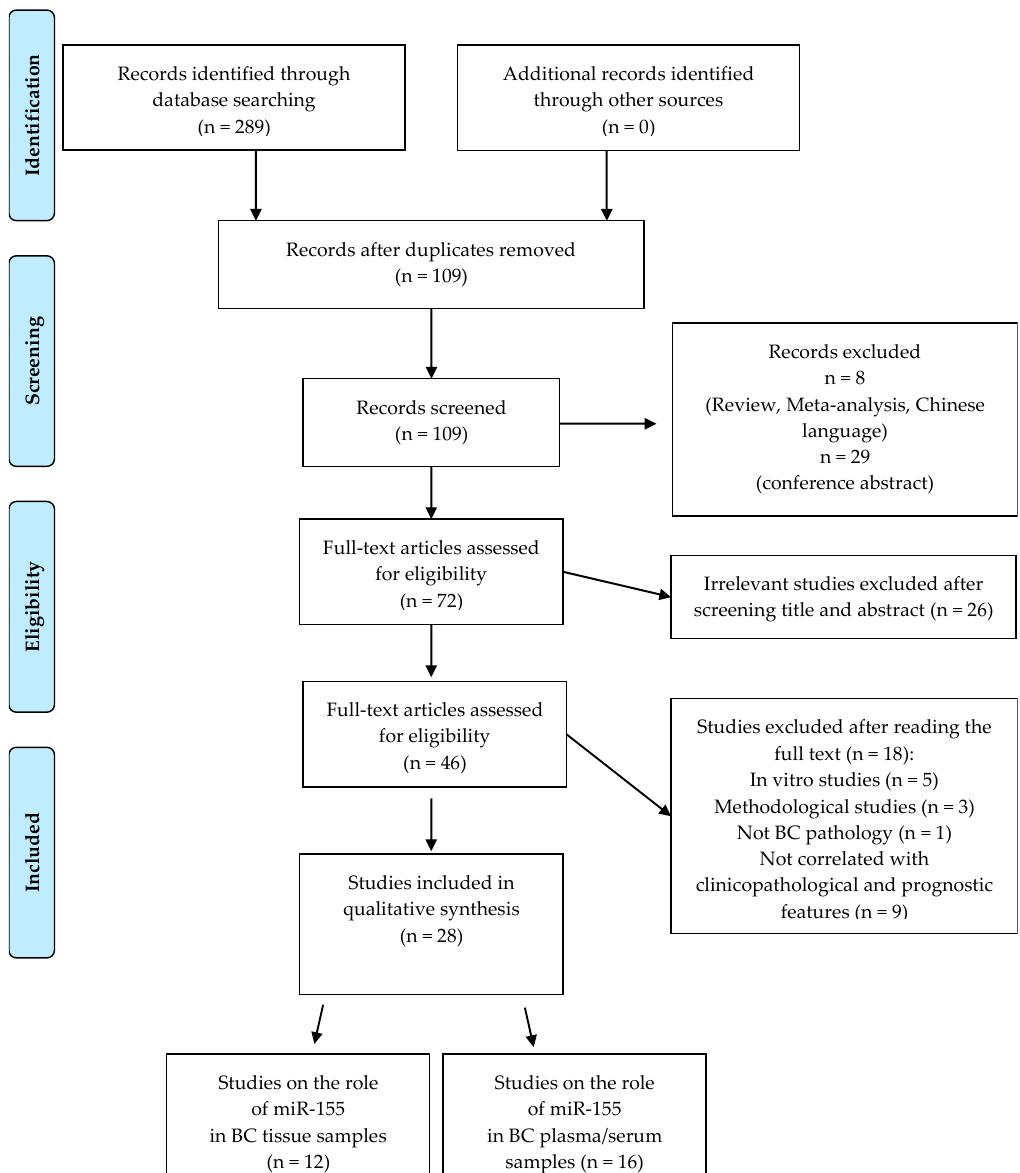
Figure 1. Flowchart for the strategy searches and selection processes.